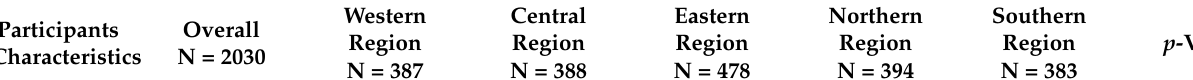
Table 3. Survey questions to assess individual and group influences of vaccine